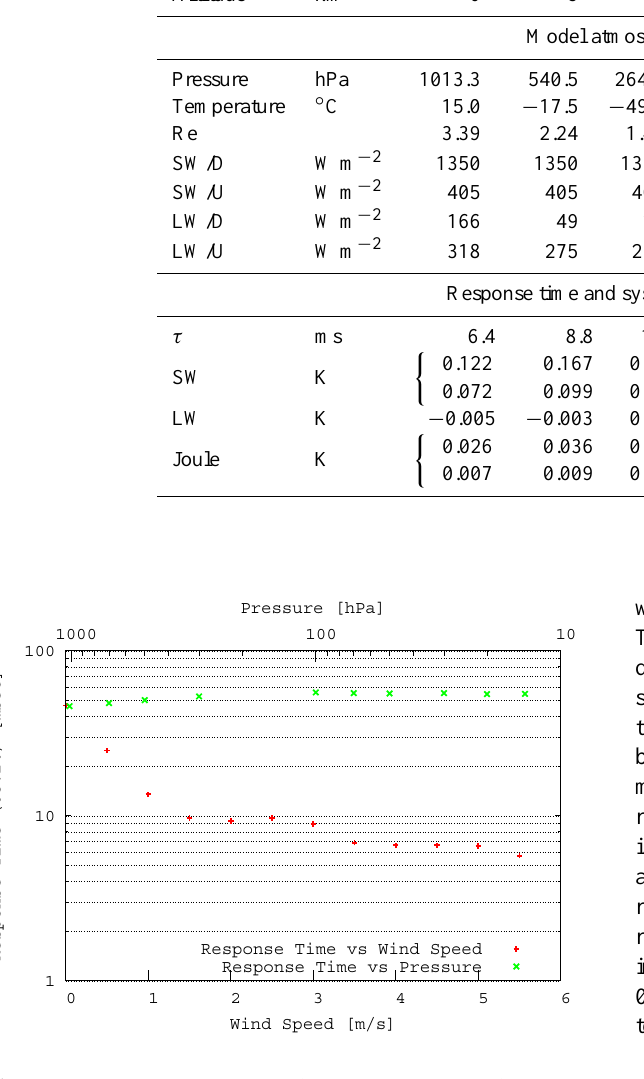
Fig. 2. Laboratory measurements of the response time τ of the tung- sten sensor. Those shown in green describe the variabilities of τ as a function of atmospheric pressure at rest (upper scale), while those in red illustrate the decrease in τ with respect to wind speed at 300K and 1atm (lower